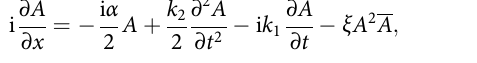
Fig. 2 Fundamental properties of the PnC WG. a The temporal response of ultrasonic wave propagations measured at the left edge of the WG when exciting the input Gaussian pulse with T 0 = 1.2 μ s and an amplitude of 1.0 V rms from the right edge. The shape of the applied wave is the same as that in Fig. 3a. The leftmost curve consists of waves propagating 1 mm, the second curve consists of waves propagating 3 mm (round-trip after 1 mm propagation), and so on. b , c The frequency dependence of the group velocity v g and the GVD coef fi cient k 2 , respectively, where the experimental and FEM simulated results are denoted as circles and solid lines, respectively. The experimental values are obtained as follows. From the fi tting of the leftmost Gaussian pulses, the center position of the wave t 1 is determined, then v g is calculated from v g = L / t 1 , where L is the propagation length. k 2 is calculated from k 2 ¼ ∂ ∂ ω 1 v , where ω is the angular g